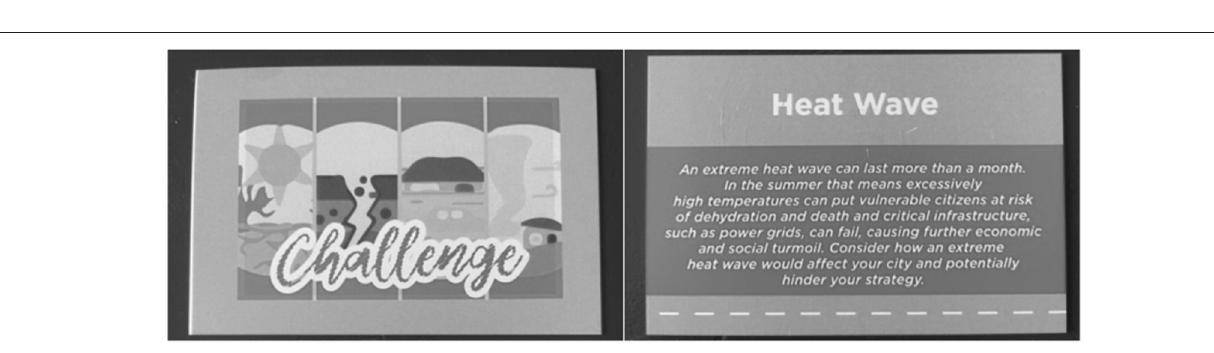
FIGURE 4 | Front and back of a challenge